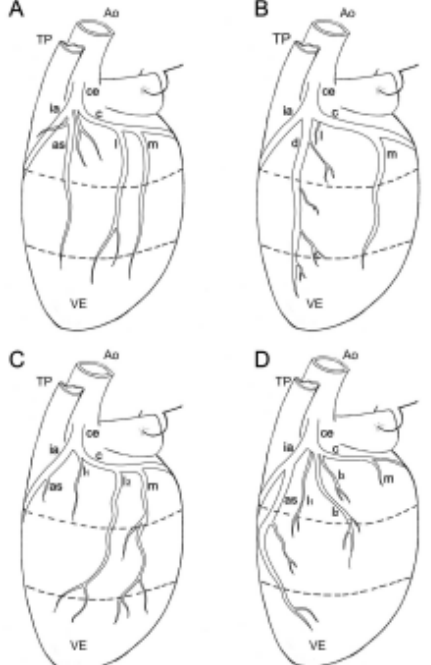
Fig. 1 - Representação esquemática da complementaridade dos ramos ântero-superior, diagonal e lateral, em vista lateral esquerda do coração (4 casos; em A, B e D: dominância da artéria coronária direita; em C: tipo de circulação coronariana balanceada). A aurícula esquerda foi rebatida. A. Coexistência dos três ramos: ântero-superior (as) longo, diagonal (d) curto e lateral (l) longo. B. Coexistência de um ramo diagonal longo com um ramo lateral curto. C. Neste caso há dois ramos laterais, um curto (l1) e um longo (L2), ao lado de um ramo ântero-superior curto. D. O ramo ântero-superior longo é ladeado por três ramos laterais: dois médios (l1 e l2) e um curto l3). Ao= aorta; TP= tronco pulmonar; VE= ventrículo esquerdo. ce= artéria coronária esquerda; ia= ramo interventricular anterior; c= ramo circunflexo; m= ramo marginal esquerdo; cd= artéria coronária direita.